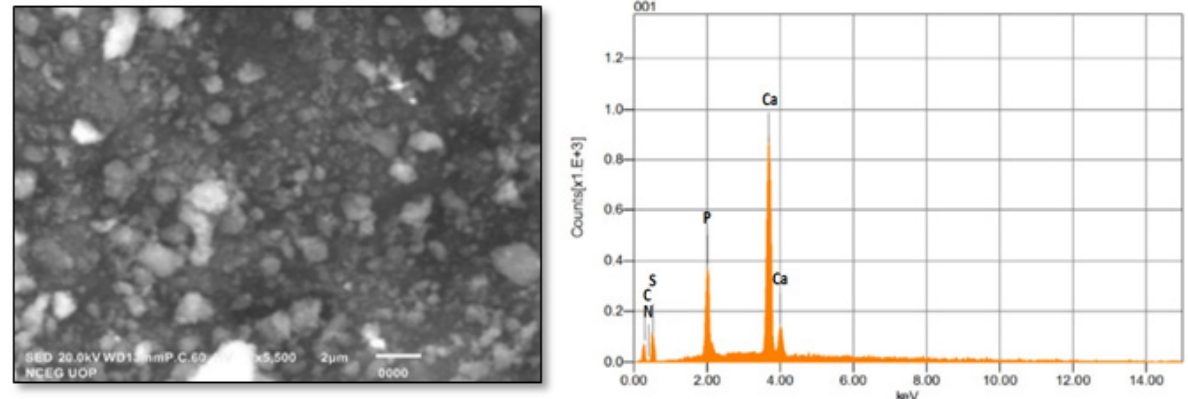
Figure 3. SEM–EDX analysis of TU–ANPs showing intense agglomeration due to Ostwald ripening where the size ranges from 40 nm to 220 nm, and characteristic signals of P and Ca of apatite at given KeV.